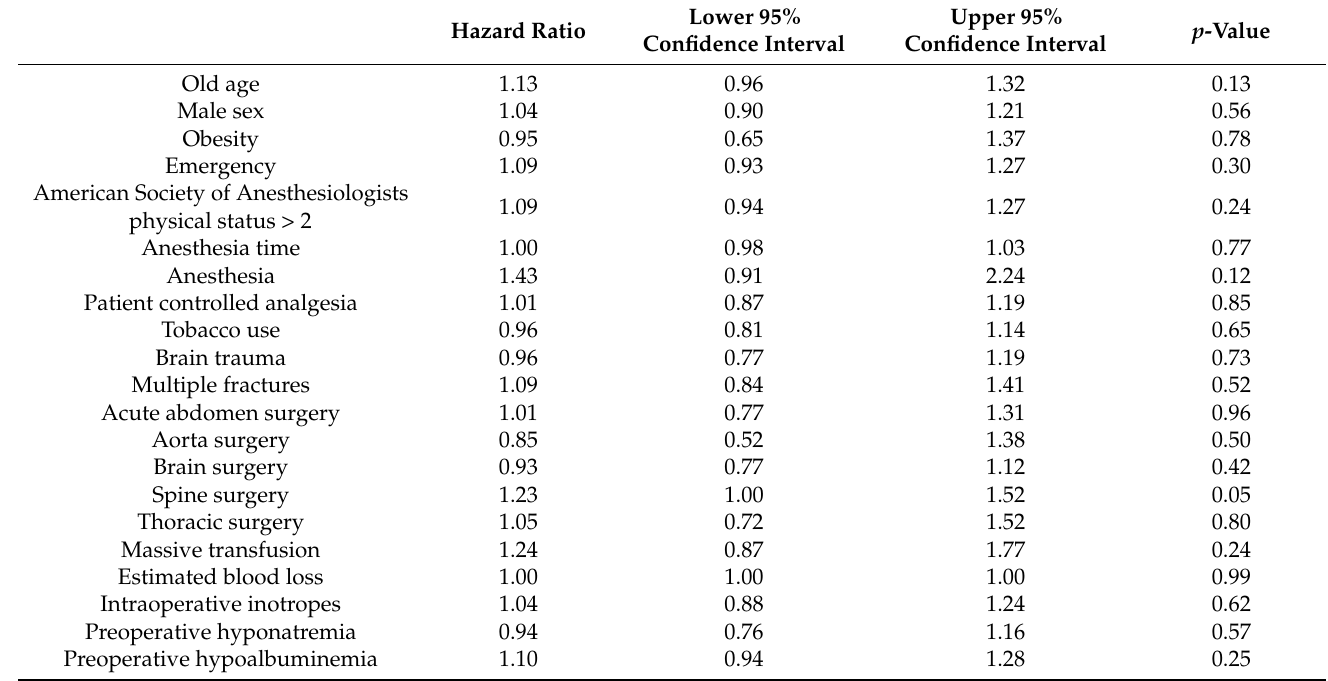
Table A1. Adjusted hazard ratios of all variables for postoperative pulmonary edema.